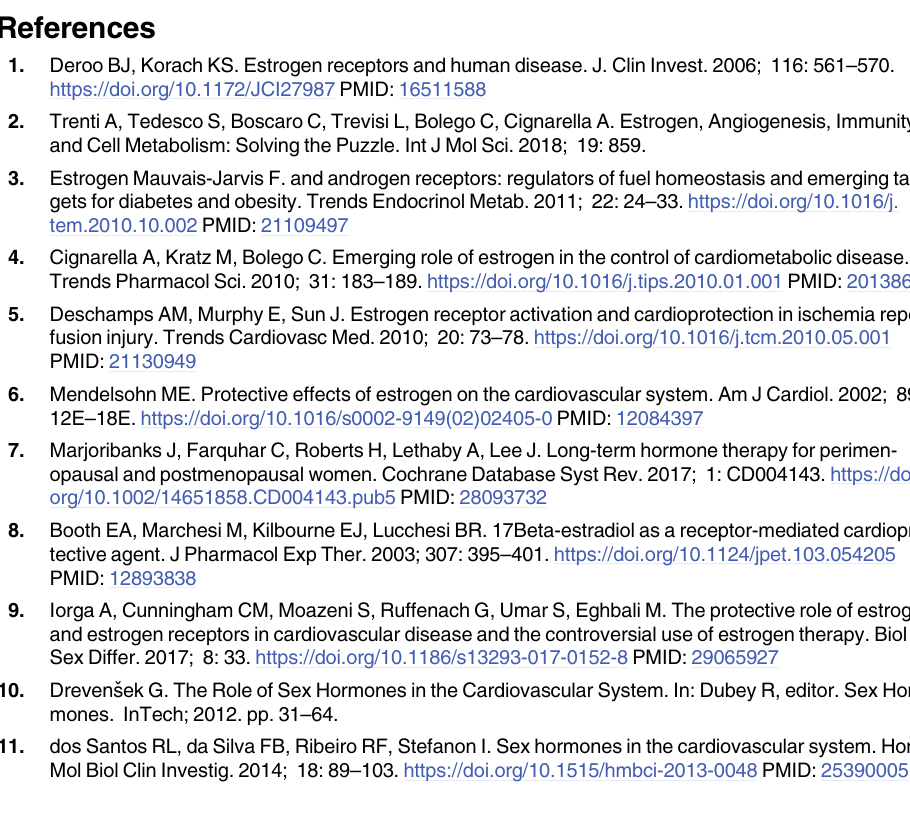
S1 Table. In vivo raw